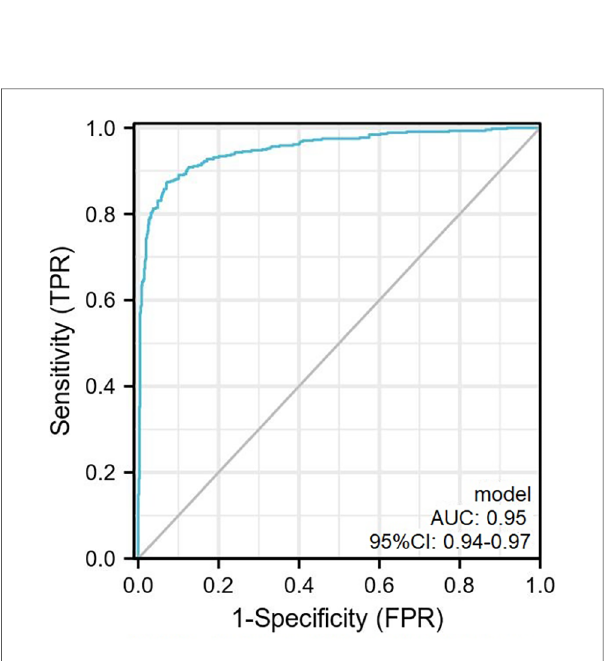
FIGURE 3 The ROC curve plotted according to the training set. The AUC of the predictive model was 0.95 (95% CI, 0.94 – 0.97) with sensitivity and speci fi city of 87.4% and 92.8% in the training set. ROC, receiver operator characteristic curve.